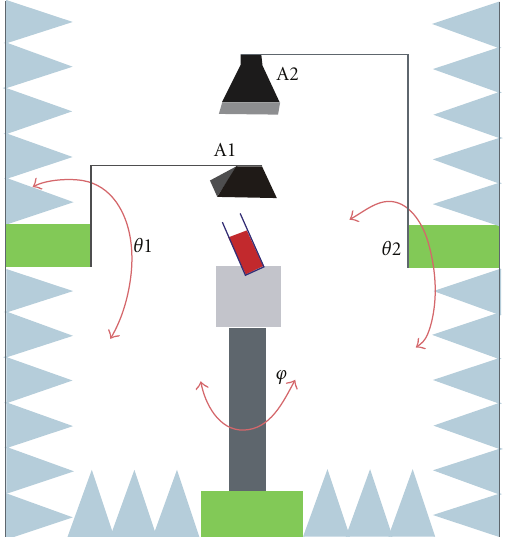
Figure 4: Two-Channel Method, antenna arrangement in anechoic chamber (TR 37.976 [7] Figure 6 . 3 . 1 . 4 .